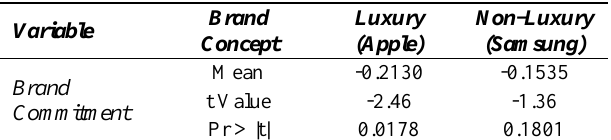
Table 3: Effect of downward brand extension on